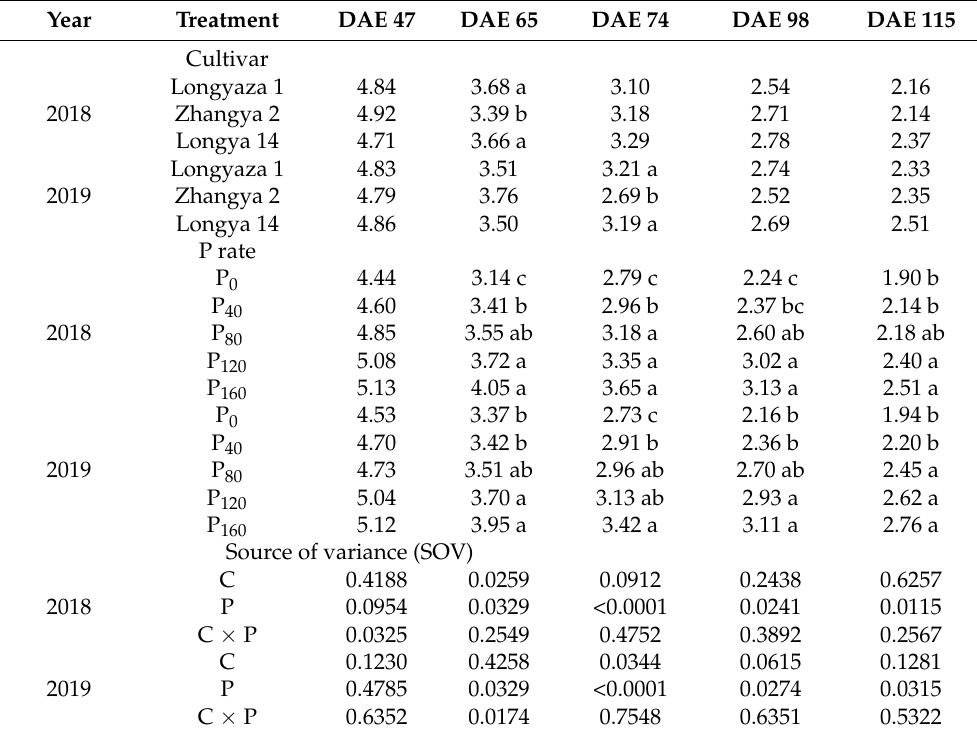
Table 4. Shoot P concentration (g kg − 1 DM) at Yongdeng in 2018 and 2019 with three cultivars flax and five phosphorus